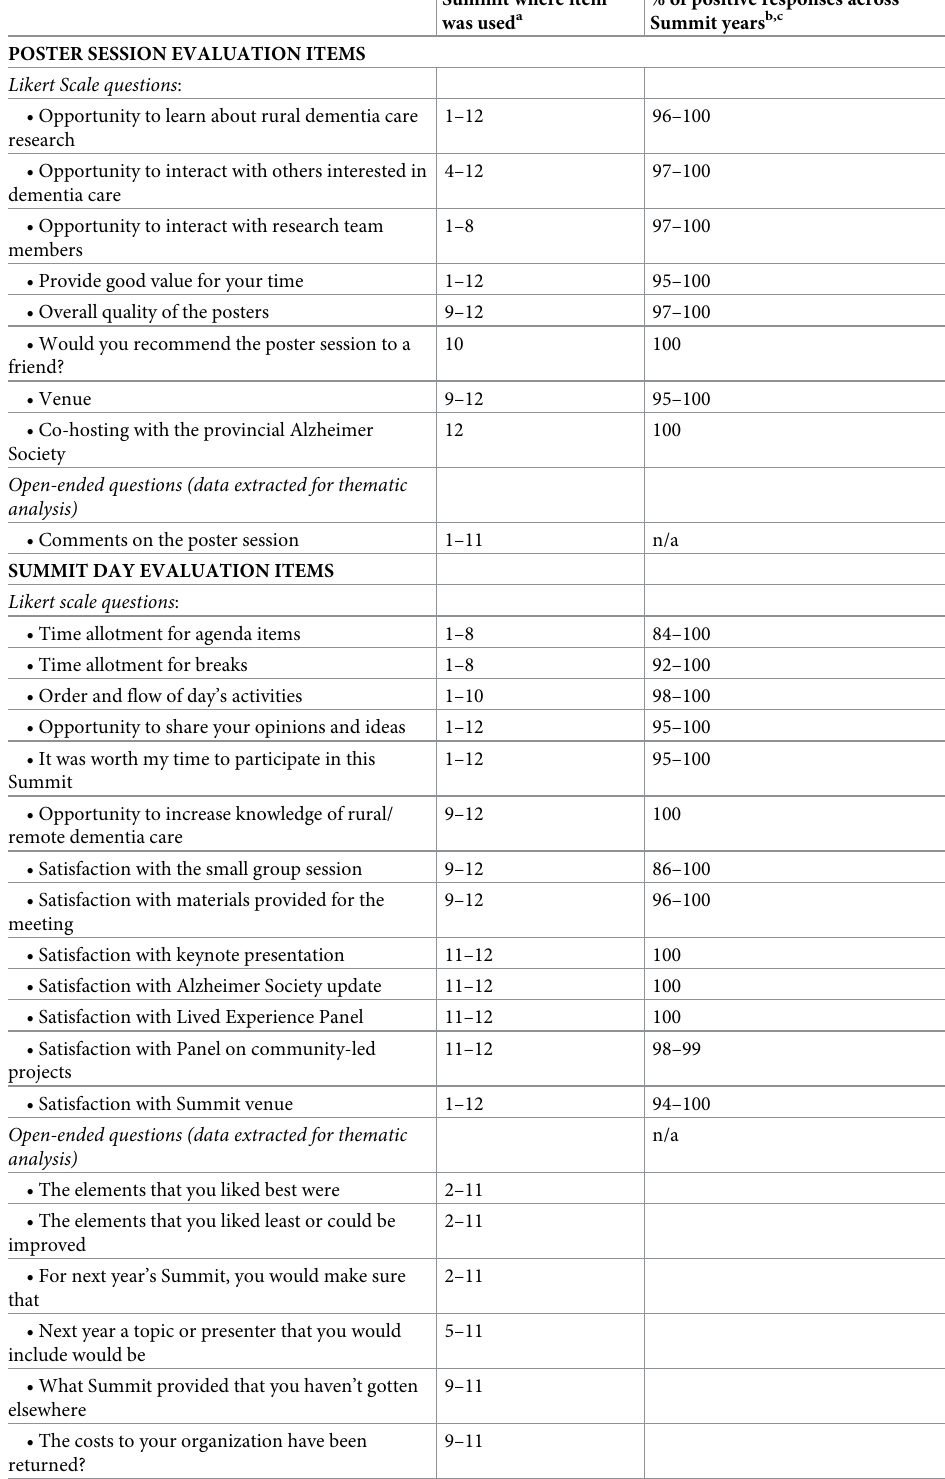
Table 1. Poster session and Summit day evaluation items: Summit 1 (2008) to Summit 12